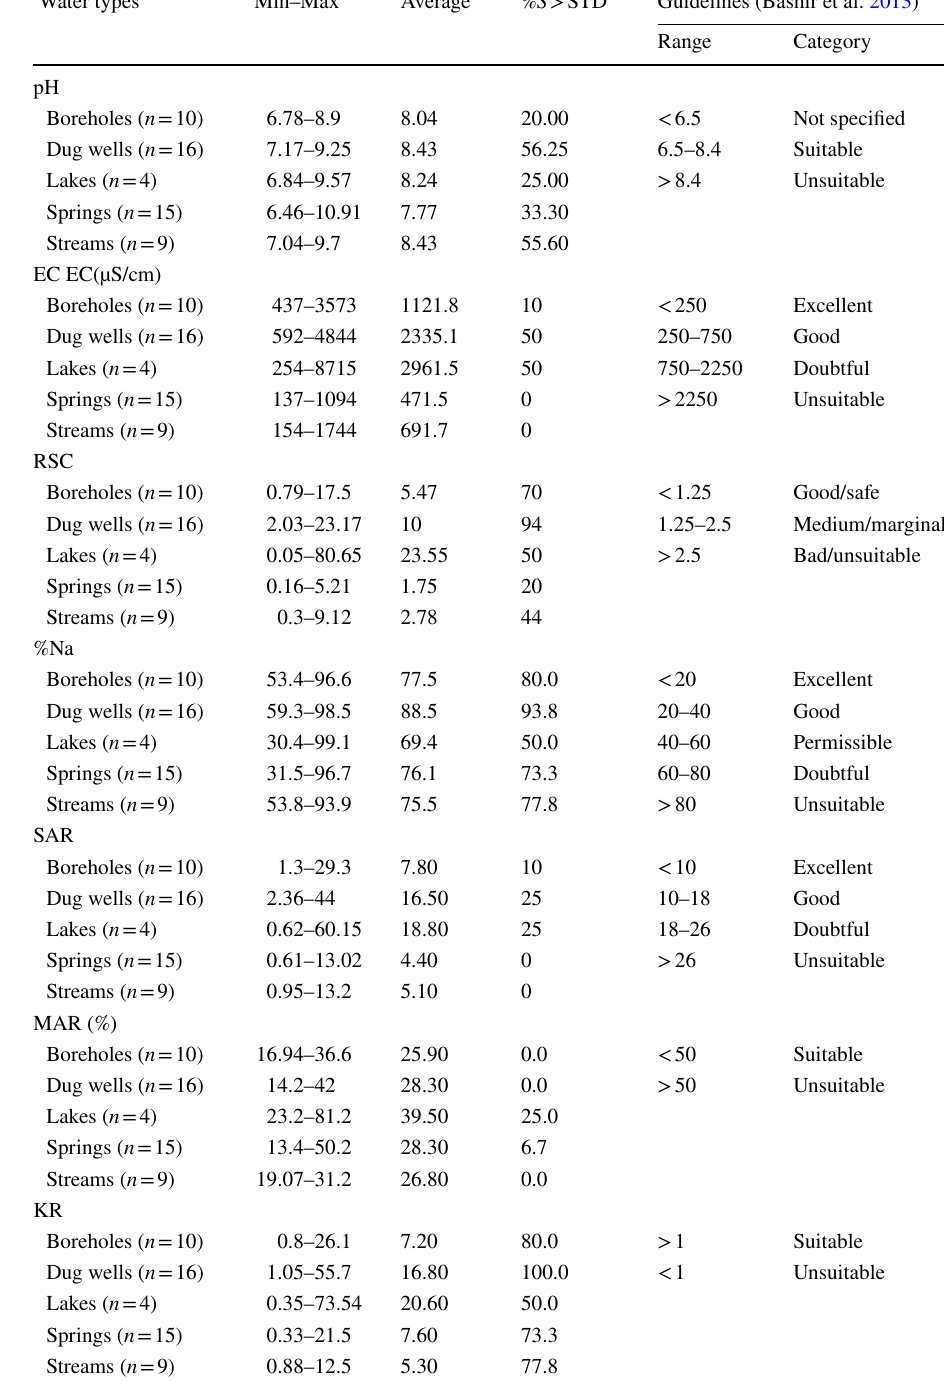
Table 4 Meru water quality parameters for irrigation